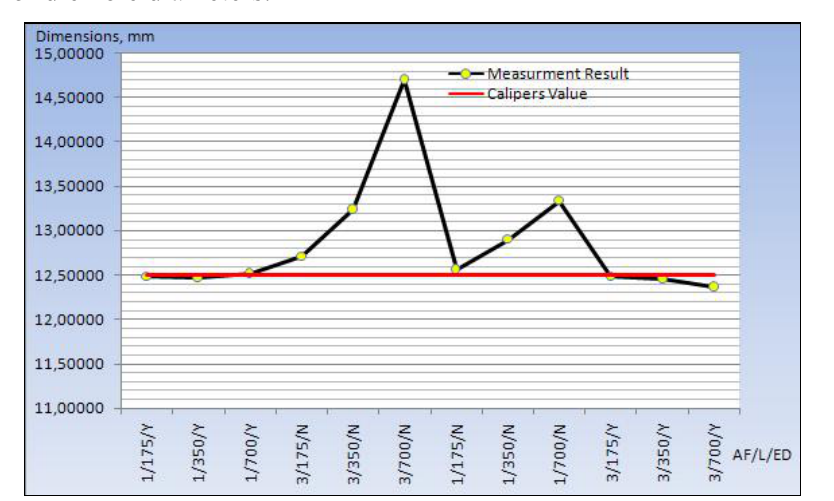
Figure 11. Comparison with the edge detection and caliper values using different lens and parameters for die hole